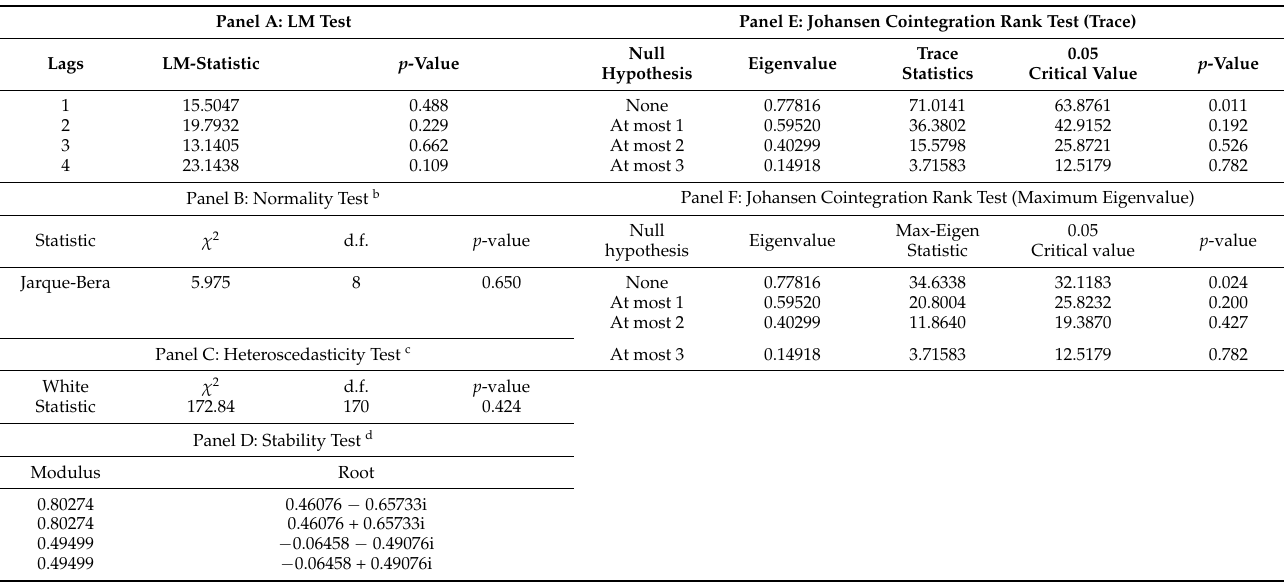
Table 4. The residual diagnostics of VAR and cointegration tests’